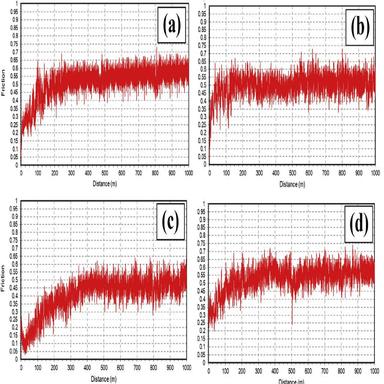
Variations of friction coefficient versus the sliding distance for (a) FSP modified AA6061 aluminum alloy and (b-d) processed AA6061-TiB2 single composites with different content of reinforcing agents as; (b) 10 wt%, (c) 20 wt%, and (d) 30 wt%.